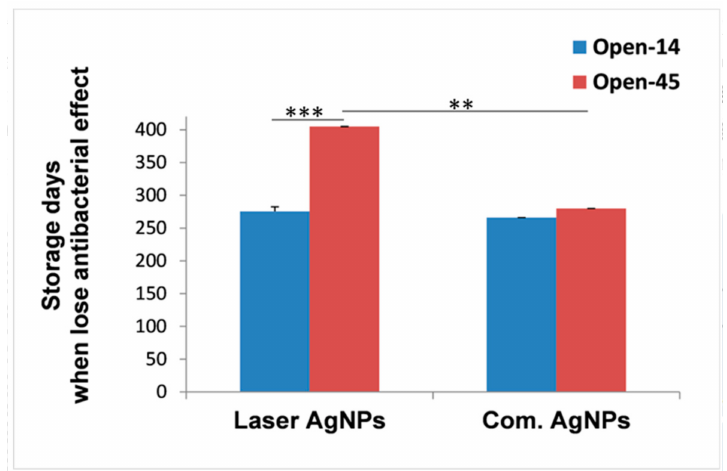
Figure 2. Impact of air exposure on the duration of antibacterial activities of AgNPs. The antibacterial effects of laser generated AgNPs or chemically generated AgNPs (Com.AgNPs) were determined every 14 days (Open-14) or every 45 days (Open-45) using the well-diffusion method until the effects completely disappeared. The average numbers of days taken for the AgNPs to loss their antibacterial activities were compared between the Open-14 and Open-45 samples regardless the storage conditions. Data are presented as mean ± SE, ** p ≤ 0.01, *** p ≤ 0.001, n =